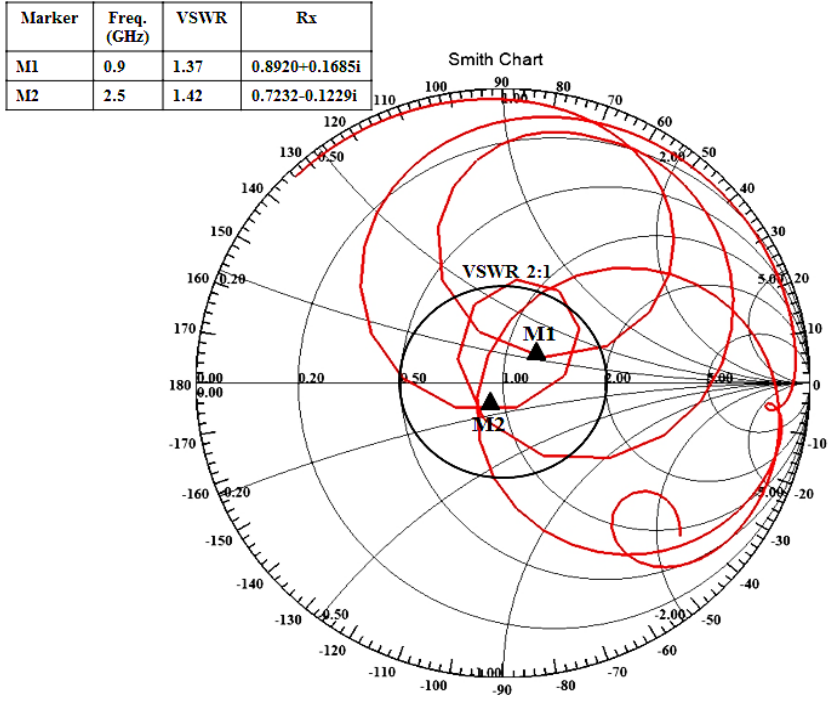
Figure 13. Smith chart of the proposed MSS loaded